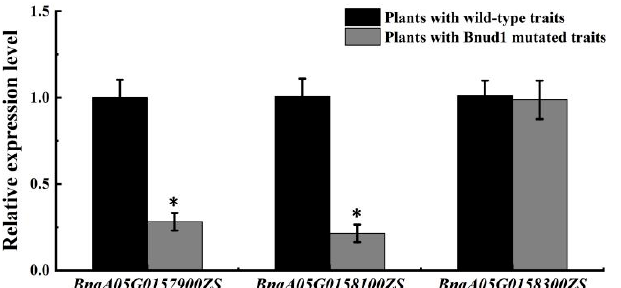
Figure 5. Differential expression of 3 mutated genes in the mapping interval in leaves of the advanced backcross population. The Actin of B. napus was used as the reference gene for normalization in qRT-PCR experiments. The relative mRNA level of genes in plants with Bnud1 mutated traits (grey) was calculated in reference to gene expression level of plants with wild-type traits (black). Values shown are means ± SD ( n = 4). * Denotes significant at probability level of 0.05.